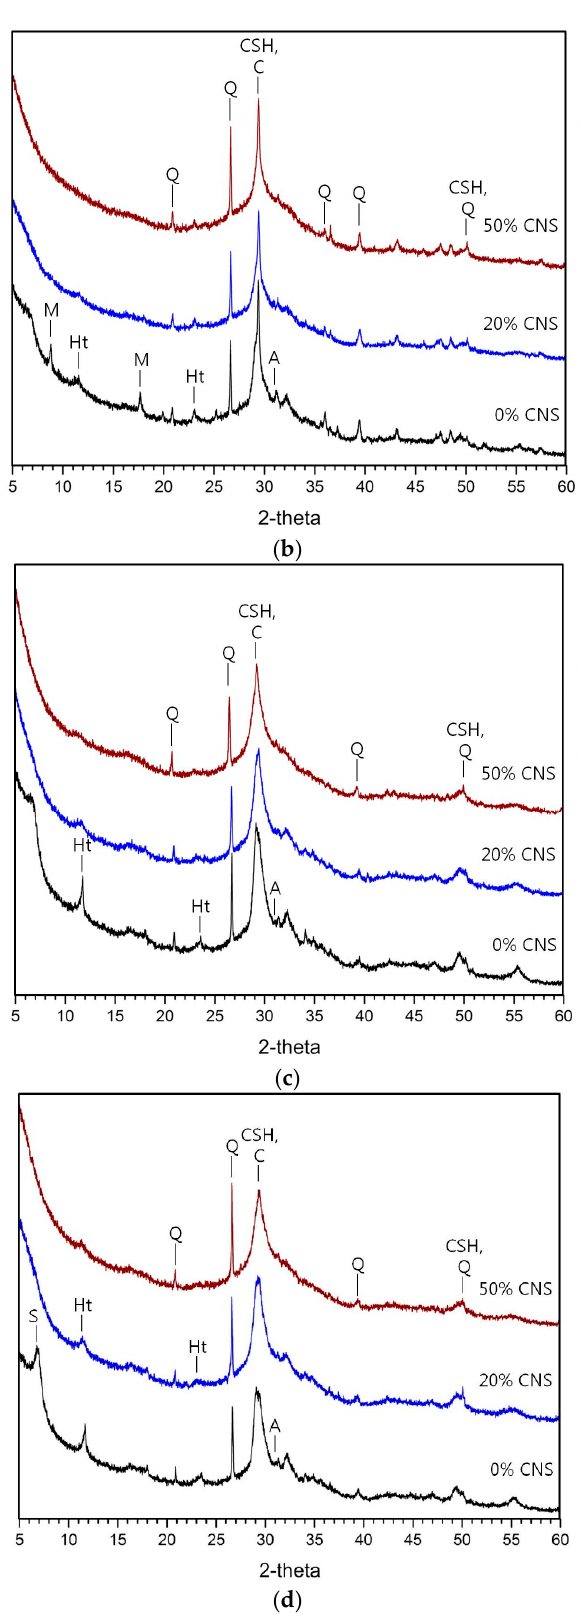
Figure 5. XRD analysis of hydration reactants: ( a ) 1-day, 5% activator samples ( b ) 28-day, 5% activator samples, ( c ) 1-day, 10% activator samples, ( d ) 28-day, 10% activator samples. M is monosulfate, C is calcite, CSH is C-S-H gel, Ht is hydrotalcite, Q is quartz, A is akermanite, S is